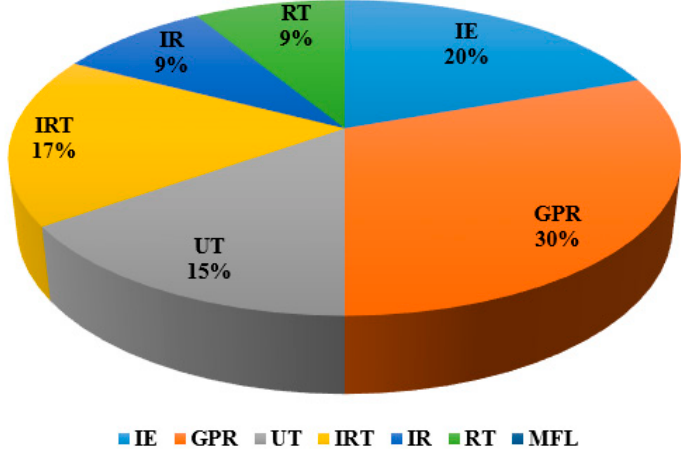
Figure 9. Statistical representation of NDT methods most applicable to detect voids.